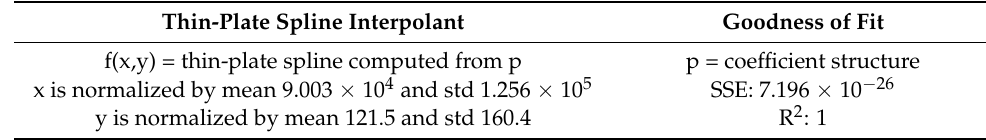
Figure 13. Relationship between Vv , T and λ values. Table 3. Gaussian curve fitting model parameters for Vv , T vs. λ . Table 3. Gaussian curve fitting model parameters for Vv , T vs. λ